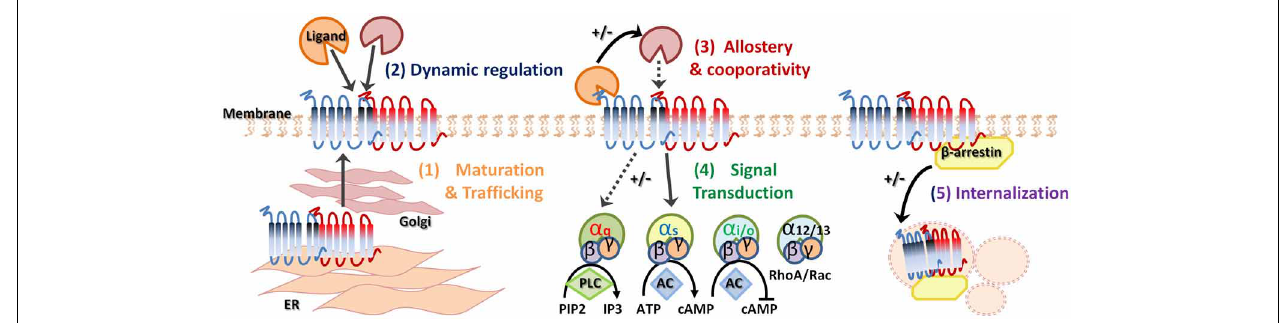
FIGURE 1 | Heterodimerization of G-protein coupled receptors. G-protein coupled receptor (GPCR) oligomerization has several biological functions and consequences. Receptor dimerization can play a role in receptor maturation and correct trafficking (1) . Specific ligand binding can dynamically regulate heterodimerization (2) and allostery can